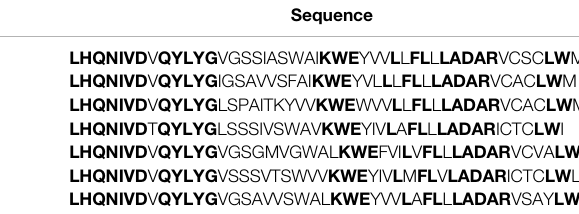
TABLE 12 | Alignment of segment 600 – 628 from various genotypes of HCV. In bold are represented the highly conserved residues. In red and blue the aromatic and small residues respectively. Genotype